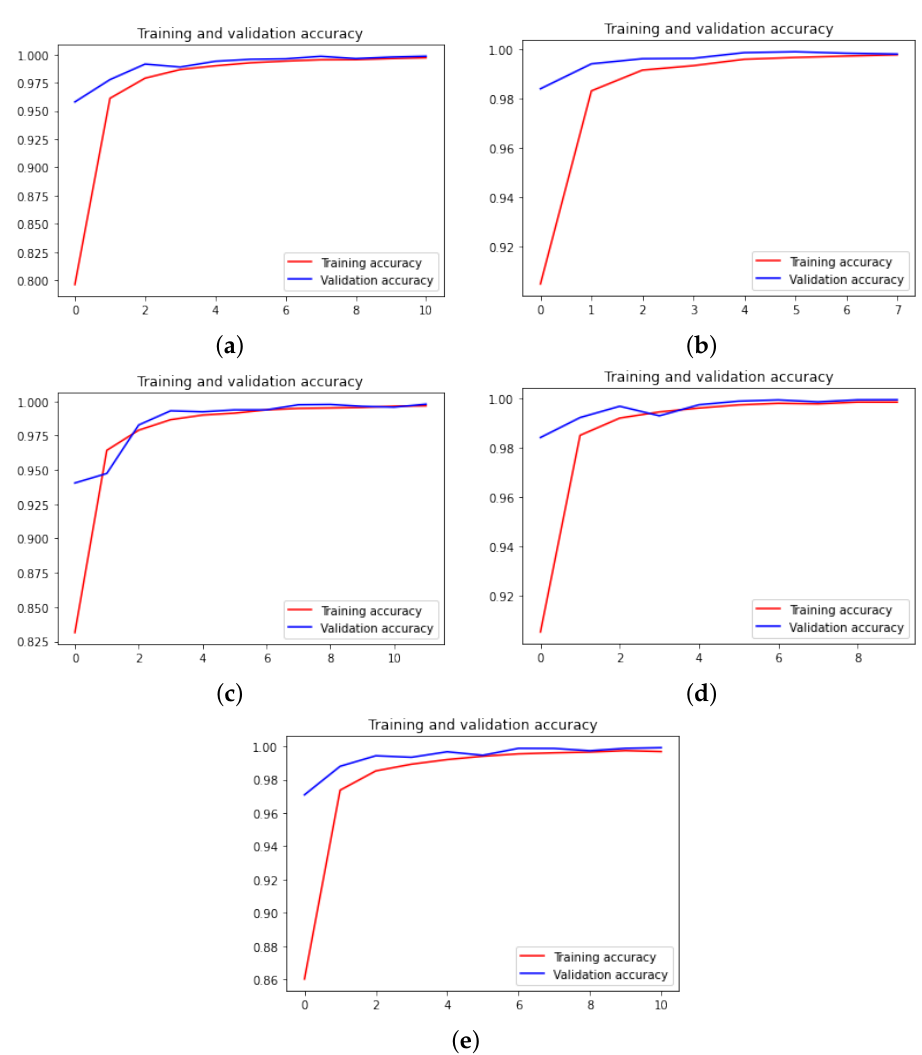
Figure 7. Accuracy curves for the traffic signs dataset. ( a ) Xception. ( b ) DensNet. ( c ) MobileNet. ( d ) ResNet. ( e )